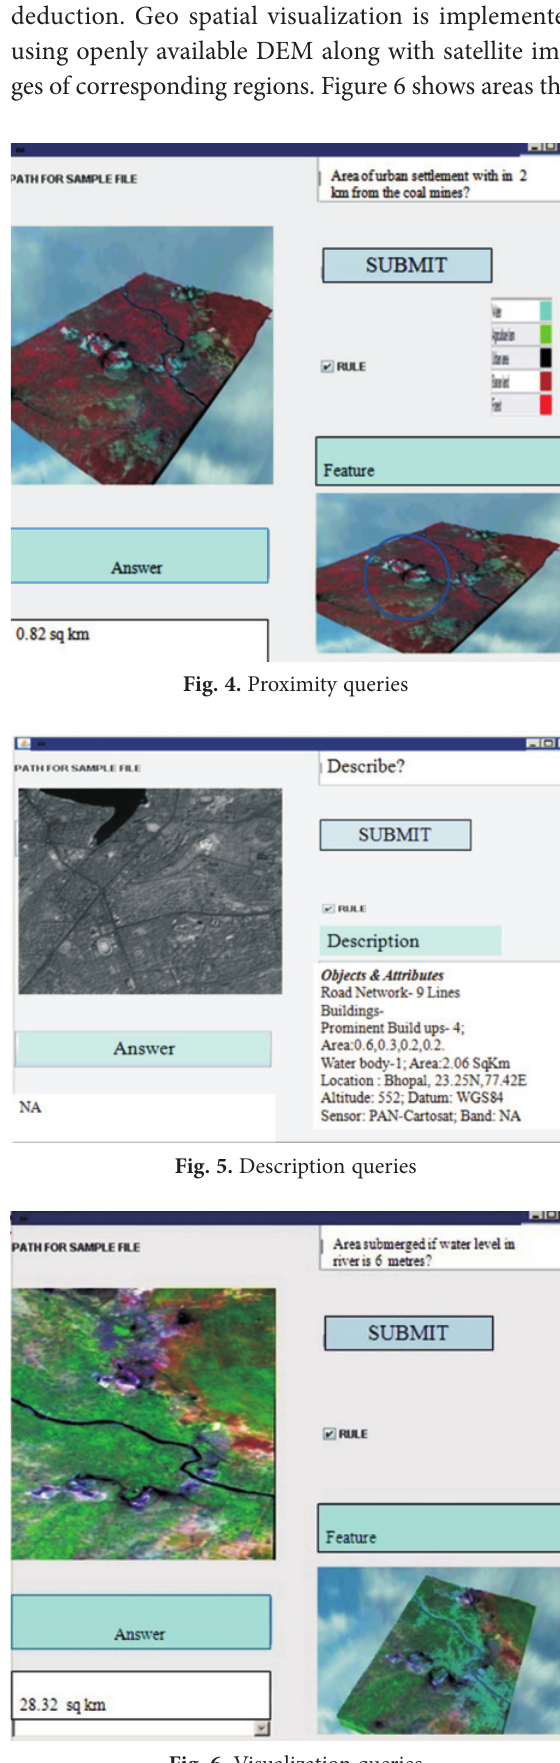
Fig. 6. Visualization